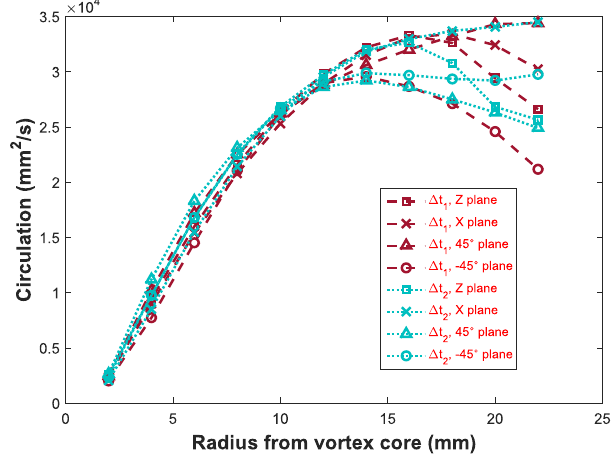
Figure 15. Circulation Γ as a function of radius from vortex core, in four different planes, for t 1 -t 2 correlation (red) and for t